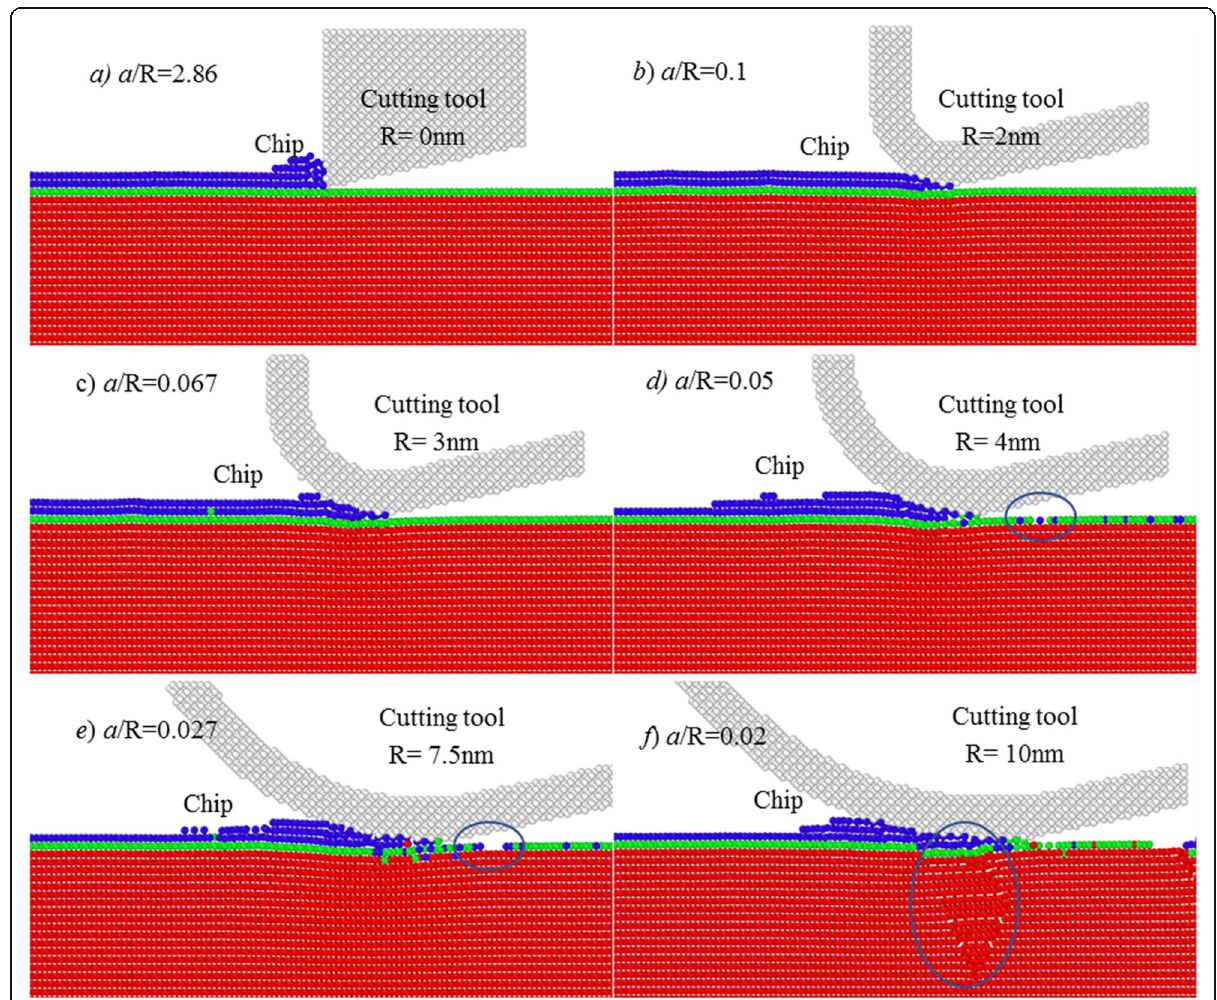
Fig. 5 Simulation results of ACS cutting at cutting depth = 2